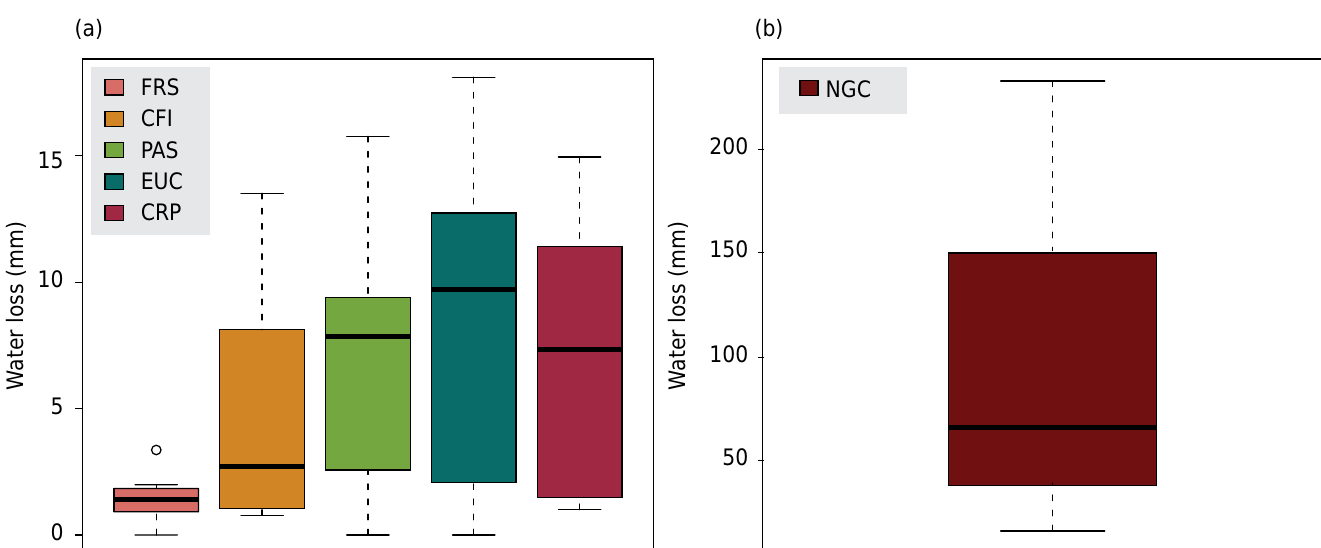
Figure 3. Boxplot of water loss for: (a) forest (FRS), crop-forest integration (CFI), pasture (PAS), eucalyptus plantation (EUC), soybean and corn crop succession (CRP); and (b) no ground cover